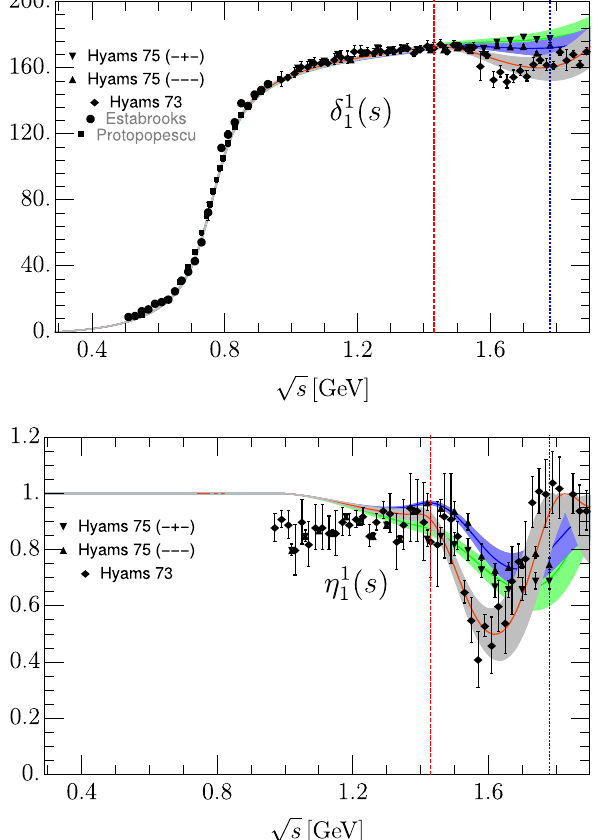
Fig. 5 Comparison between our three P-wave solutions and scattering data. The gray, blue and green bands correspond to solution I, II and III, respectively. The red dashed vertical line separates the region where the fits describe both data and dispersive results, from the region above where the parameterization is just fitted to the data. Namely, above 1.4 GeVsolutionIisfittedto [2,3](soliddiamonds),solutionIIto[4](solid upward triangles) and solution III to [58] (solid downward triangles). The data from [6] (solid squares), [71] (solid circles) are just shown for completeness. The blue dotted vertical line depicts the energy of the last data point of solutions II and